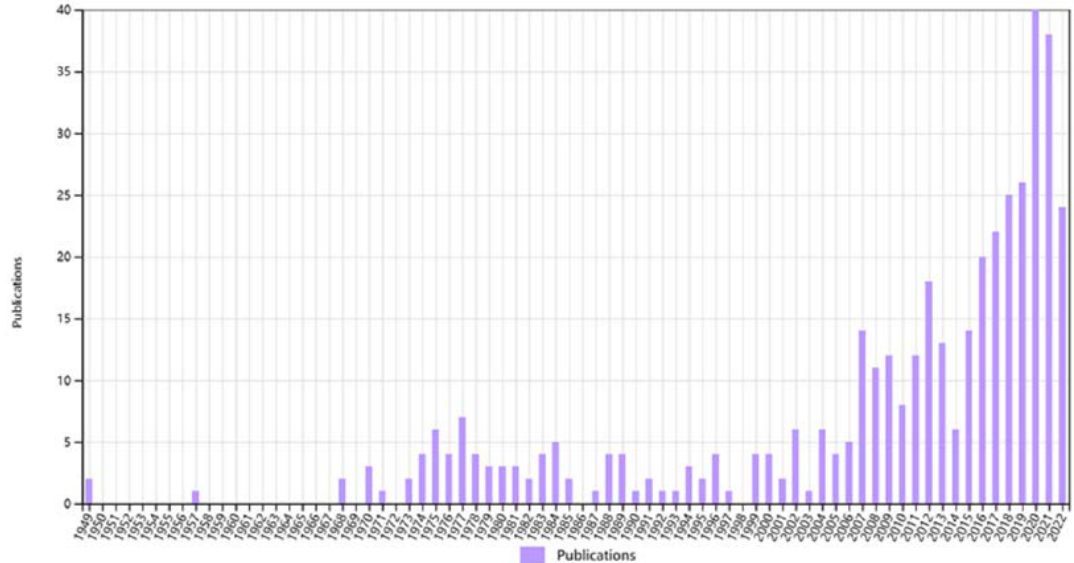
Figure 1. A bibliometric study based on Scopus or Web of Science database.